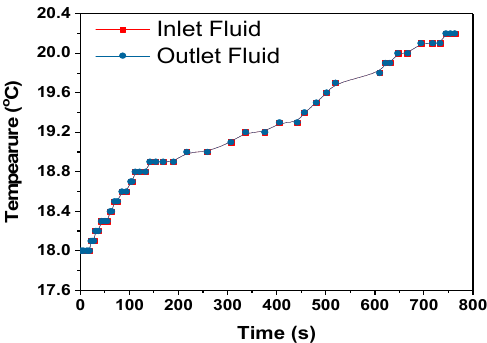
Figure 17. The coolant temperature variation measured at the inlet and outlet of the heat exchanger during 3C wet discharge of the battery module.